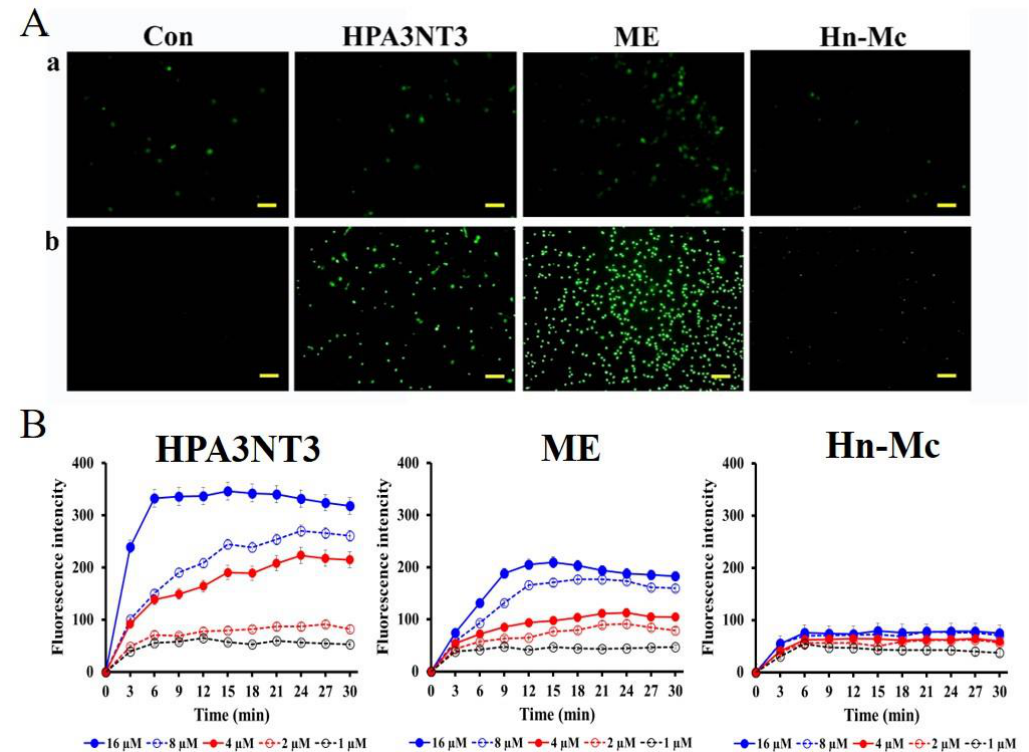
Figure 3. Permeability of the antimicrobial peptides on fungal membranes. Fungal cells were visualized using a fluorescence microscope ( A ) and through fluorescence emission of C. tropicalis cells analyzed using a microtiter plate spectrophotometer ( B ). HPA3NT3 (left), ME (middle), and Hn-Mc (right) (8 µM each) were incubated with SYTOX Green-pretreated C. tropicalis ( a ) and F. oxysporum ( b ) cells.